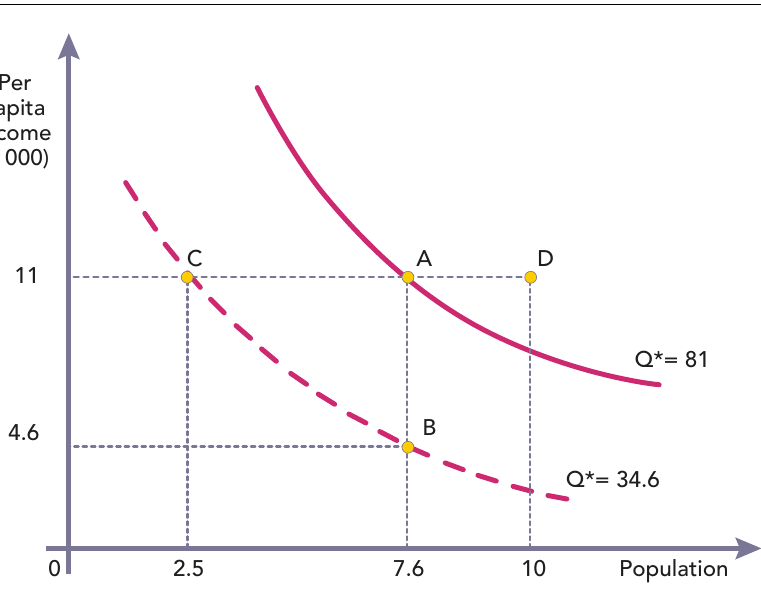
Figure 1. The trade-off between standard of living and population at ecological